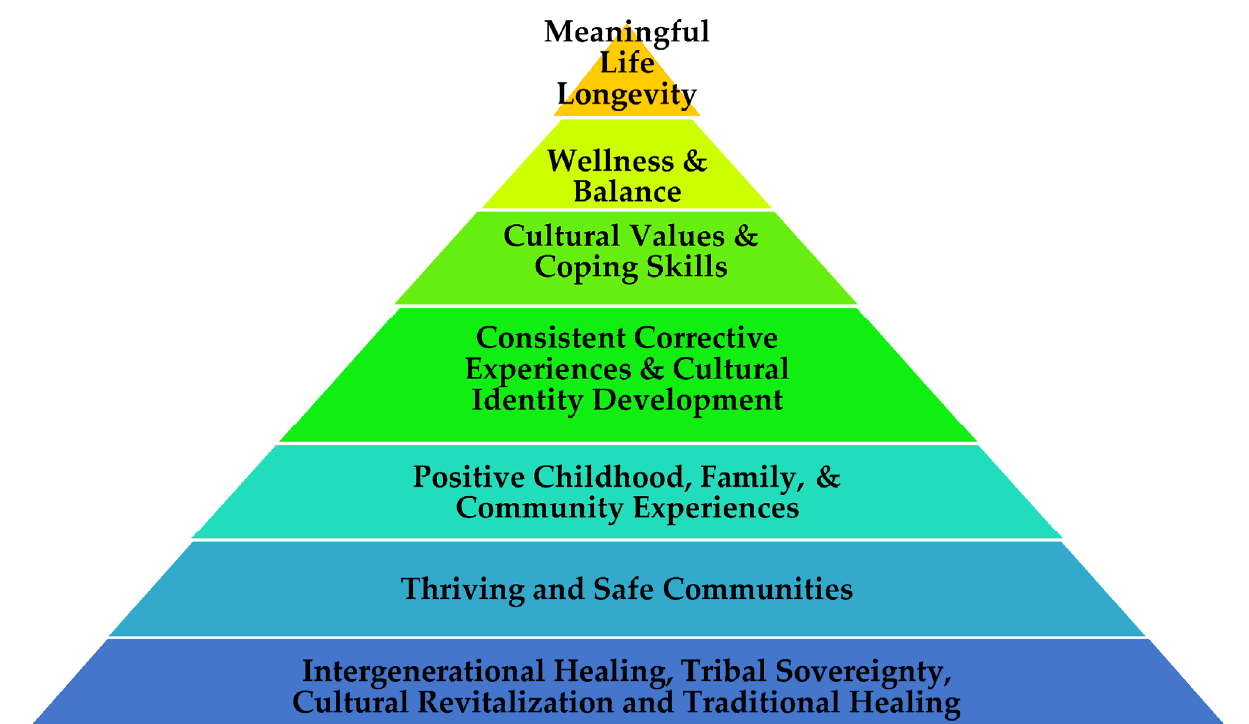
Figure 1. The Indigenous Wellness Pyramid provides a scalable, positive pathway toward increased well-being in Indigenous communities, and it is the opposite side of the ACEs pyramid. The shift toward resiliency, positive pathways, health promotion, and protective factors is reflected in the seven areas of the model.